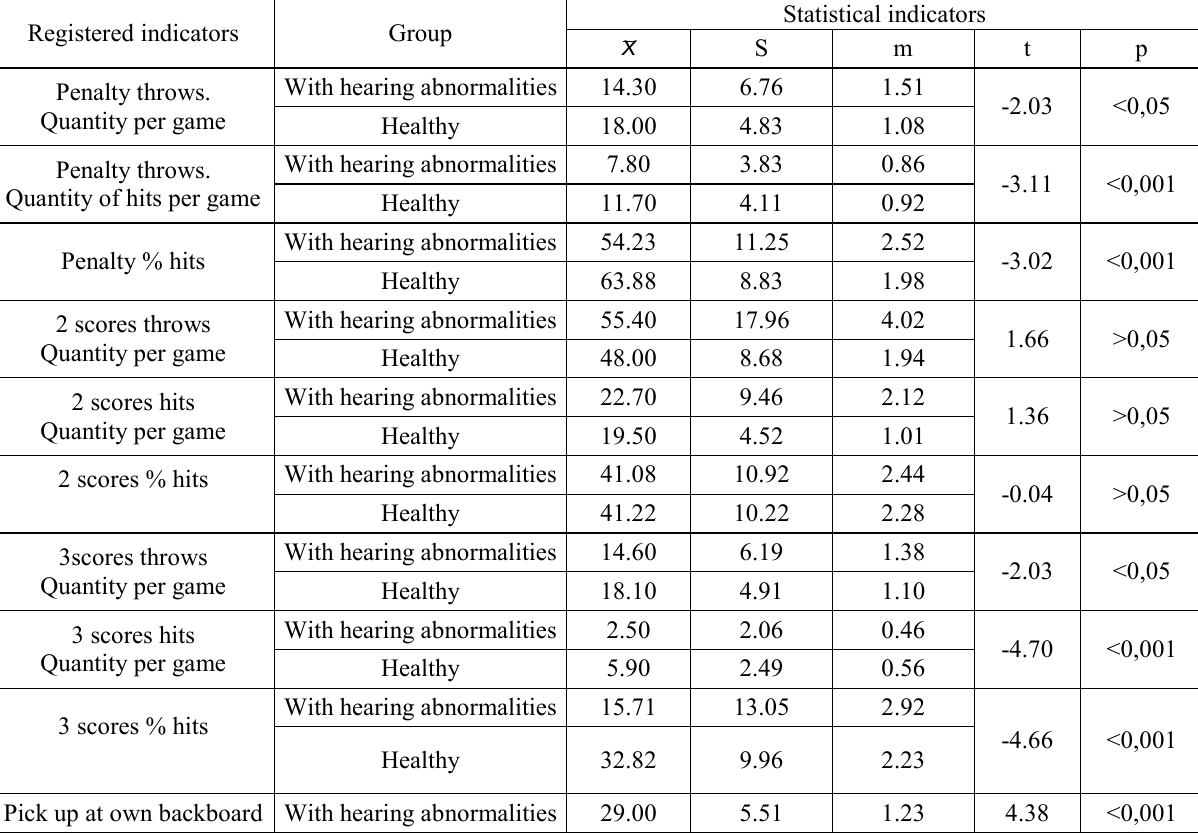
Indicators of competition activity of healthy female basketball players (n=20)and female basketball players with abnormalities of hearing